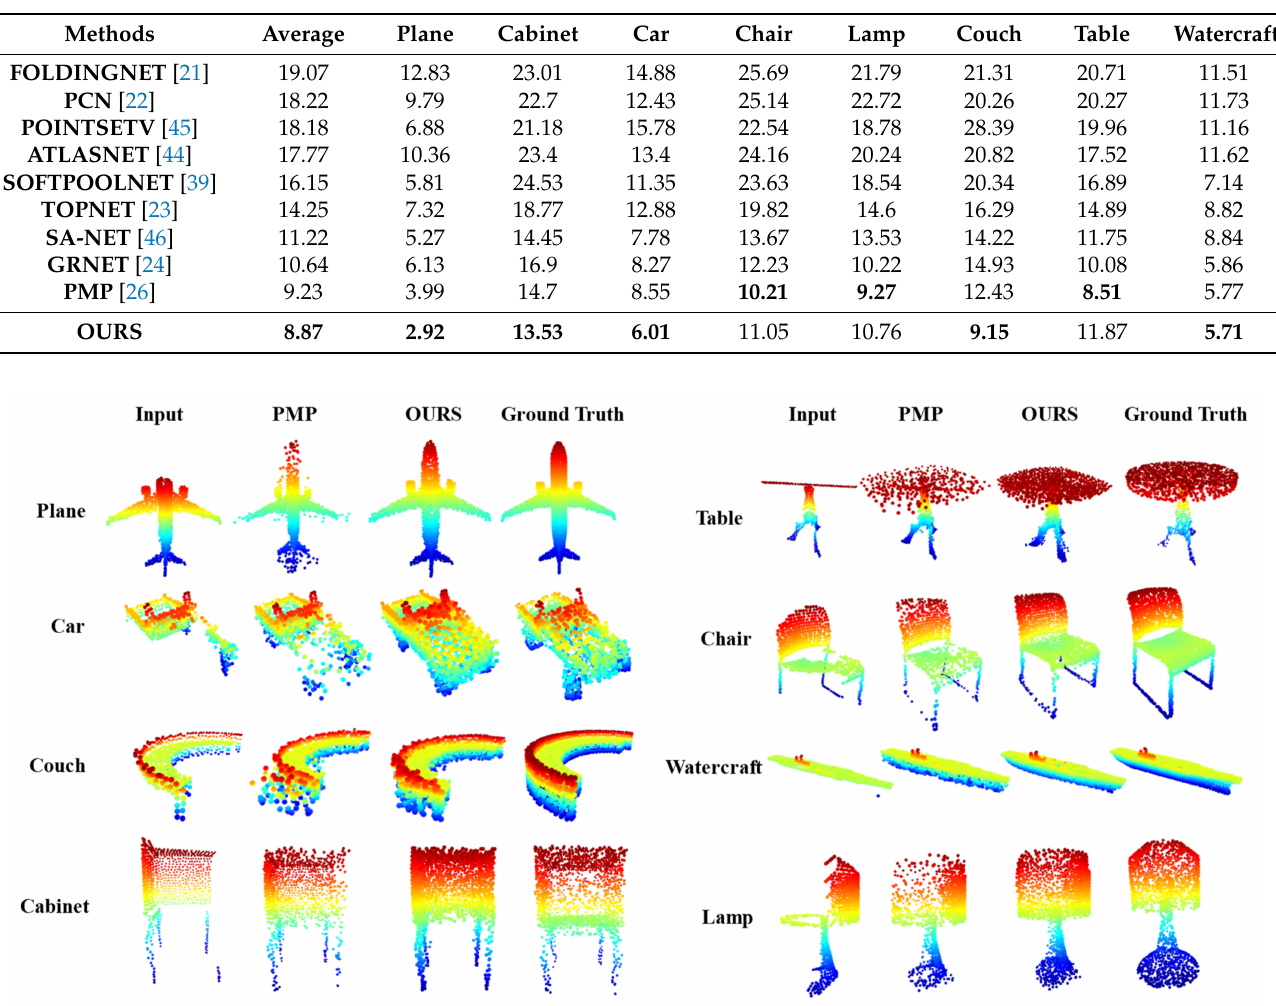
Table 3. Point completion results on Completion3D dataset in terms of per-point chamfer distance (CD) with L2 norm computed on 2048 points and multiplied by 10 4 . The best results are highlighted in bold (lower is better).